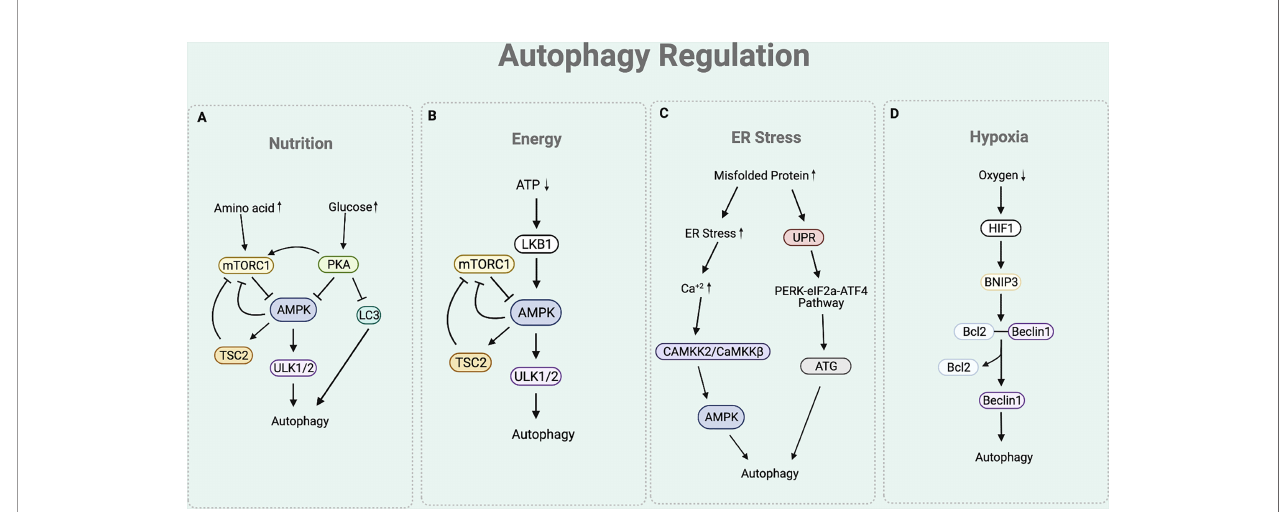
FIGURE 2 | Autophagy Regulation. (A) The nutritional cue leads to the mTORC1 and cAMP-dependent-PKA-dependent pathways. In a nutrient rich condition (presence of amino acids), mTORC1 inhibits the interaction between ULK complex and AMPK by phosphorylating ULK1. Under nutrient depleted condition, mTORC1 is inactivated to allow the AMPK to interact with ULK1 for autophagy initiation. Under nutrition rich condition (presence of glucose), PKA inhibits autophagy process by phosphorylating LC3, activating mTORC1, and inactivating AMPK. (B) Under ATP depleted condition, LKB1 senses the decreased ATP/AMP ratio and activates AMPK, which inactivates mTORC1 by activating TSC2 and phosphorylating Raptor of mTORC1. This eventually leads to the upregulation of autophagy. (C) Under ER stress condition, the cytosolic Ca +2 level increases to activate CAMKK2/CaMKK b that activates AMPK. AMPK helps to inhibit mTORC1 activity to induce autophagy by activating TSC2 and phosphorylating Raptor. The ER stress condition also triggers an UPR process that responds to an accumulation of unfolded proteins. UPR activates PERK-eIF2a-ATF4 pathway, which upregulates the production of ATGs necessary for autophagy process. (D) Under hypoxia condition, there is an increased expression of HIF1 that upregulates the expression of BNIP-3. BNIP3 promoter contains HRE that is activated by the HIF1. The BH3 functional domain of BNIP3 competitively interferes with the interaction between the Beclin1 and Bcl-2. This disruption liberates Beclin1 to be used for the autophagy initiation